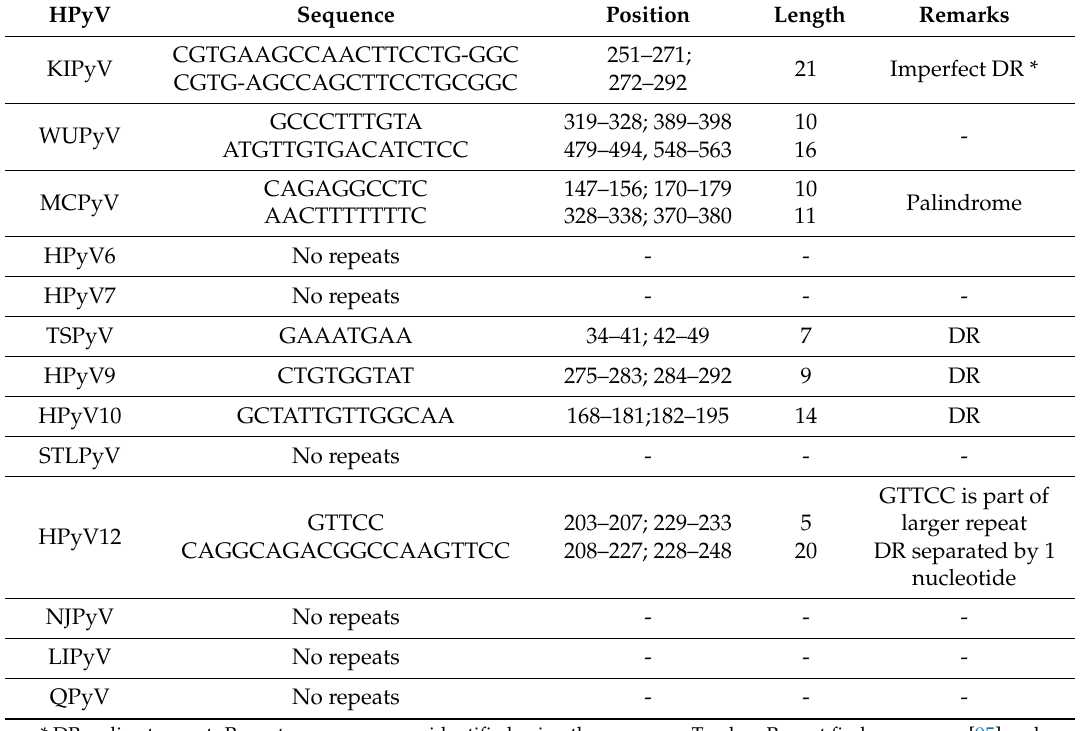
Table 2. Repeat sequences in the noncoding regions of the novel human polyomaviruses.